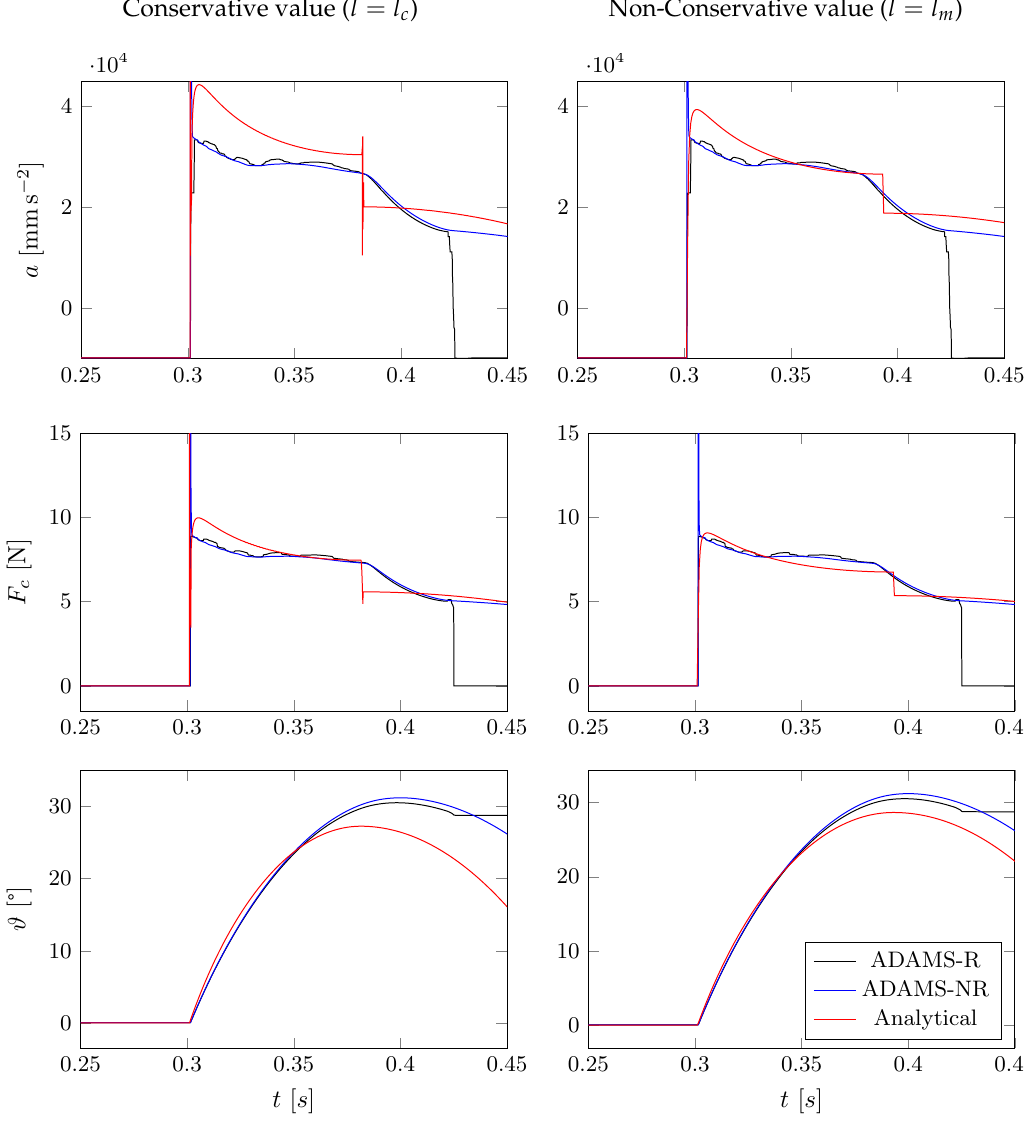
Figure 14. Comparison between ADAMS simulations with and without ratchets and the MATLAB-based analytical simulation for two leg length parameter chosen: in the top row the lander acceleration, in the middle row the contact force between soil and lander pad, and in the bottom layer the evolution of the leg joint